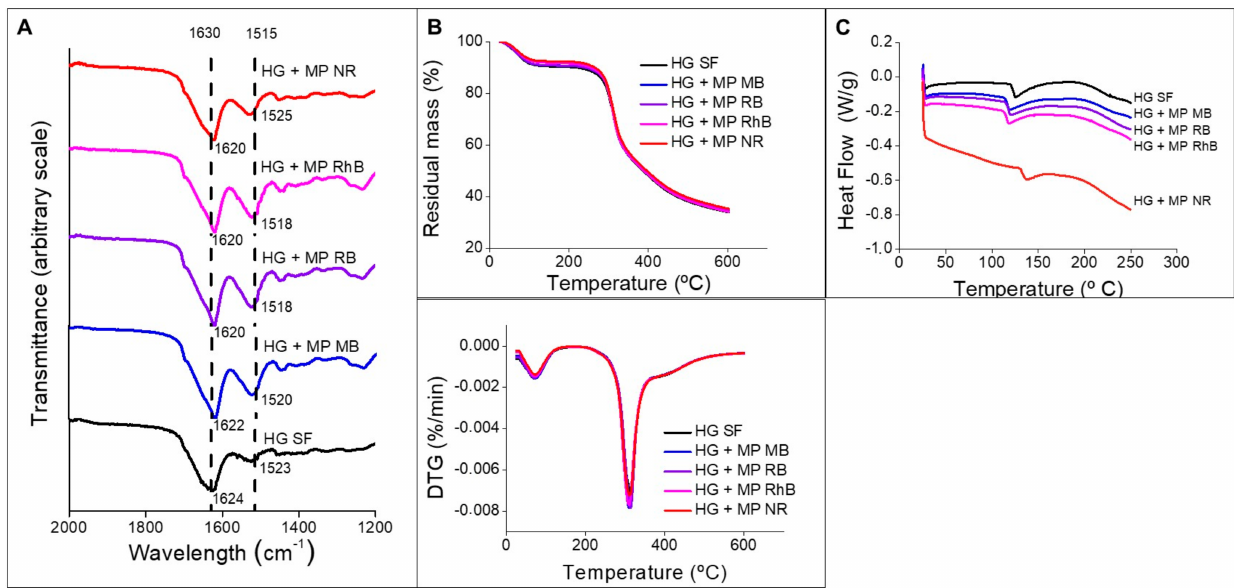
Figure 7. ( A ) FTIR spectra of SF hydrogels with and without microparticles loaded with dyes. ( B ) Thermogravimetric analysis (TGA) and derivative thermogravimetry (DTG) thermograms of SF hydrogels with and without microparticles loaded with dyes. ( C ) DSC thermogram of SF hydrogels with and without microparticles loaded with dyes.